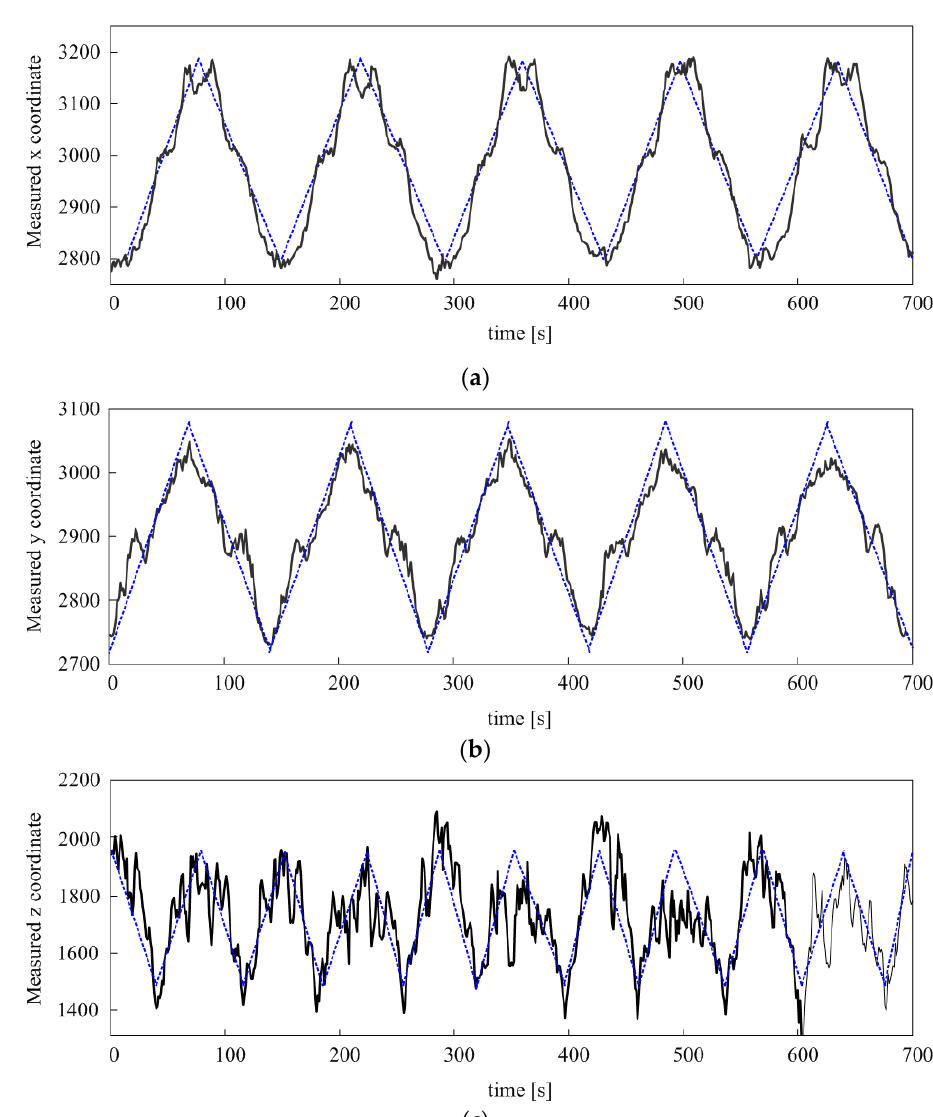
Figure 9. Repetitive moving measurement data; ( a ) x, ( b ) y, and ( c ) z axes. The blue dot line represents the moving curve of the triaxial Cartesian robot along the reference coordinate.